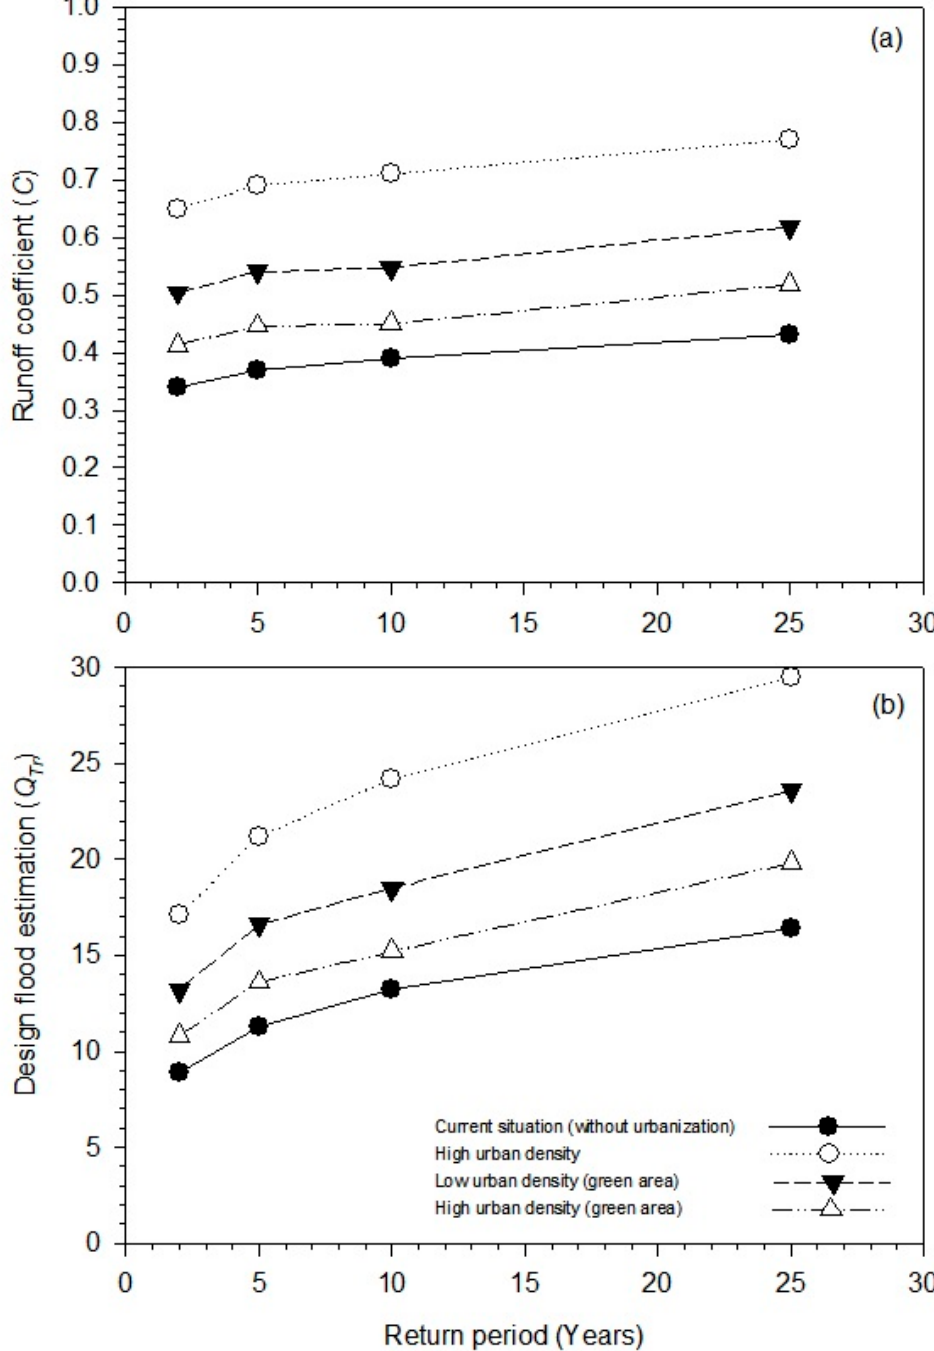
Figure 5. Runoff coefficients ( a ) and flood design estimation ( b ) of the modeled scenarios under different urbanization levels for a 25-year return period.